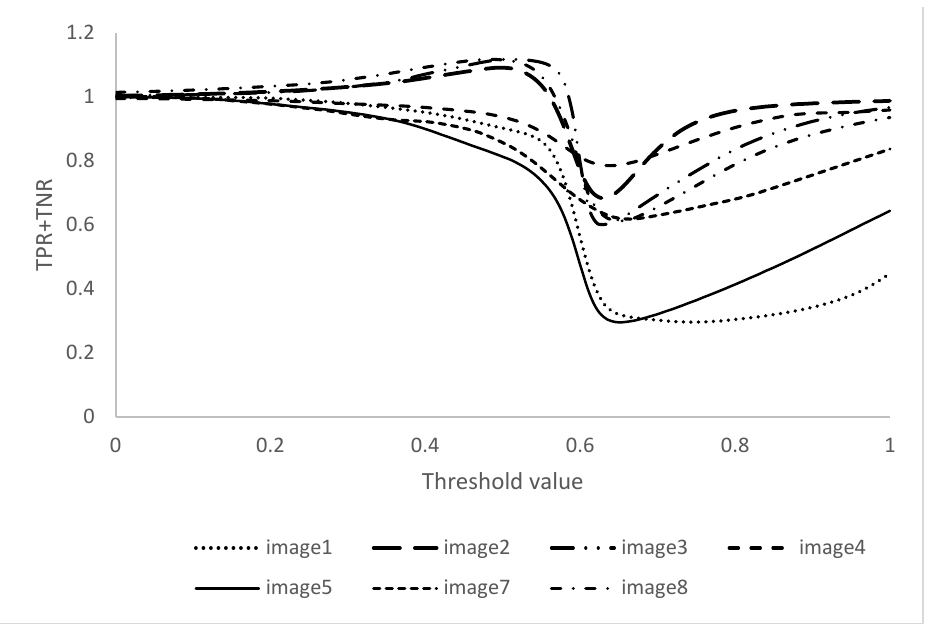
Figure 14. Comparison of total correct predictions for different threshold values of all images.